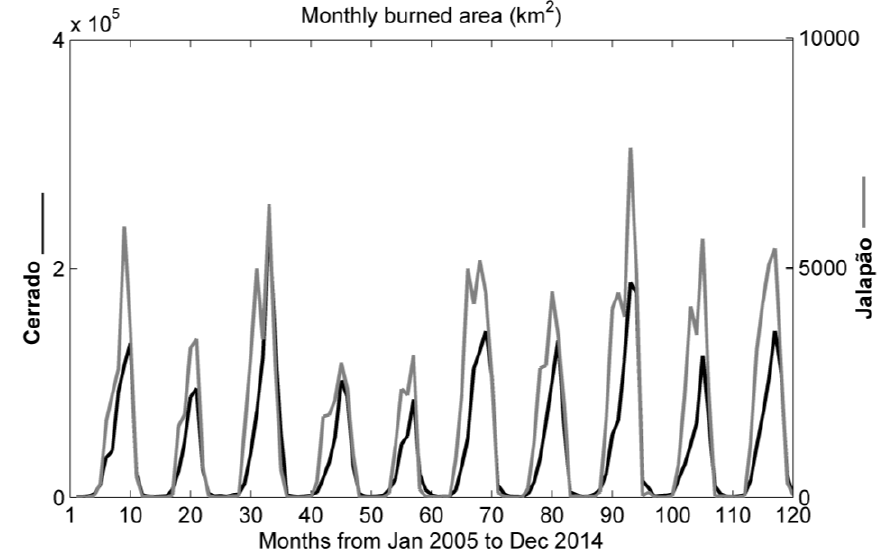
Figure 8. Monthly burned area (km 2 ) for the 10-year period over Cerrado (black curve) and Jalapão (gray